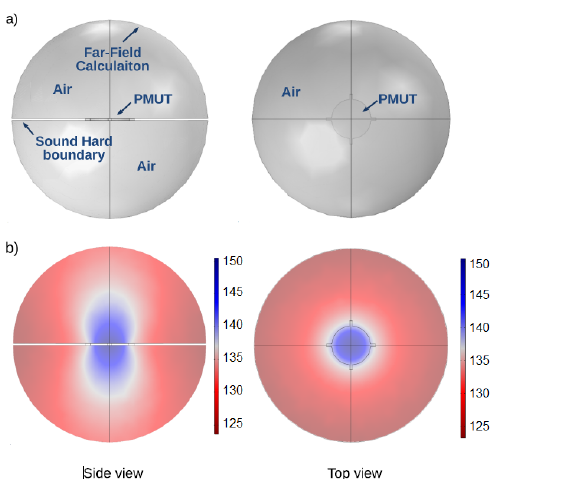
Figure 5. COMSOL simulation. ( a ) model used for the simulations and ( b ) simulation results of acoustic pressure level in